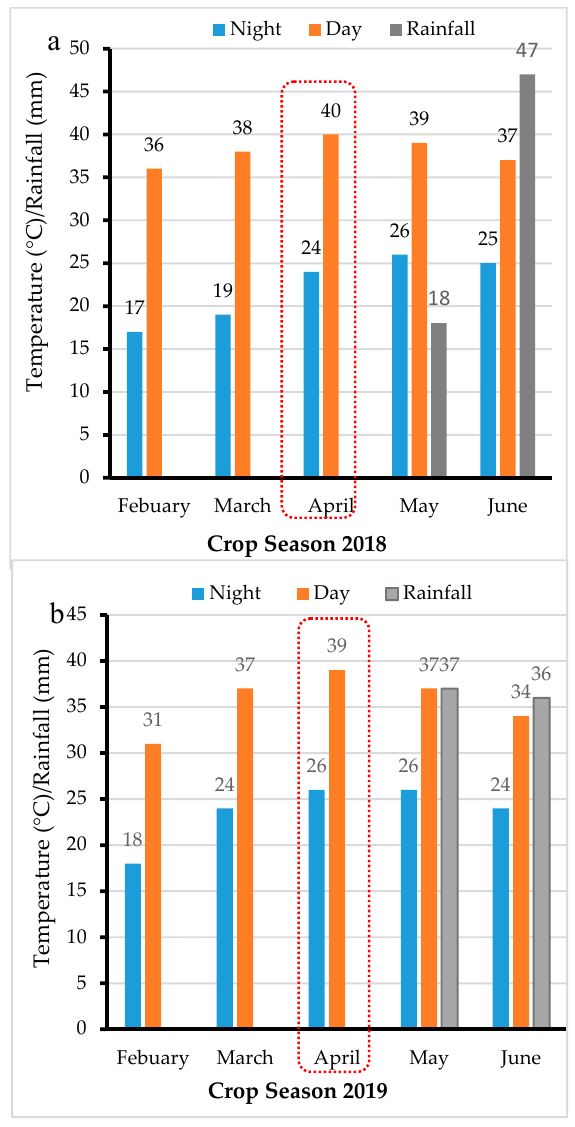
Figure 1. Monthly average temperature and rainfall during the experimental period at Kadawa, Nigeria. Note: Dotted rectangles represent flowering and early grain filling stages. ( a ) Trial period in 2018 ( b ) Trial period in 2019.